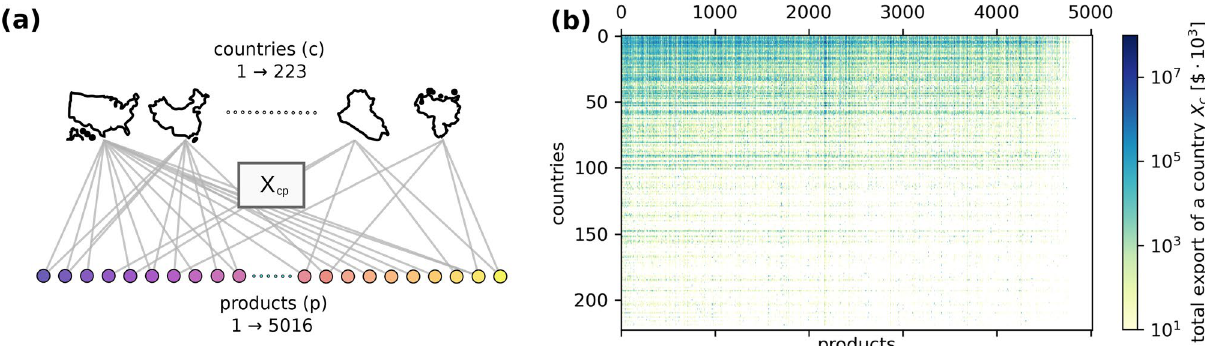
Figure 1. ( a ) Sketch of the bipartite network associated to the weighted bi-adjacency matrix X cp . Every link represents the overall amount (in thousands of current US dollars) of product p exported by a country c towards the rest of the World in a given year. ( b ) X cp matrix. Countries (rows) are sorted from top to bottom with decreasing diversity H c , while products (columns) are sorted from left to right with decreasing ubiquity H p . Sorting according to these criteria highlights a nested structure of the bipartite